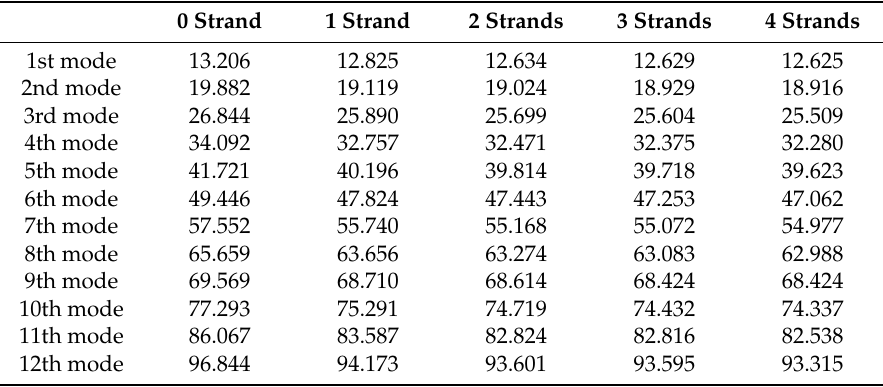
Figure 7. Frequency response function for a different number of broken strands. Table 1. Change in natural frequency with the number of broken strands.